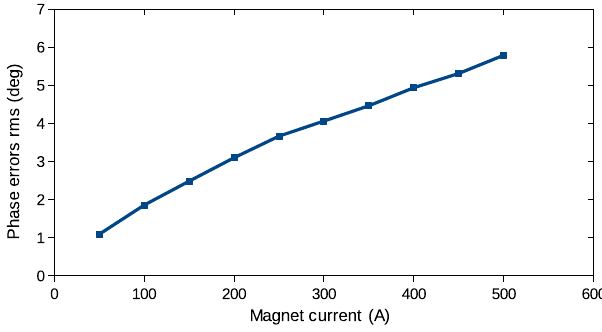
FIG. 11. Measured phase errors as a function of magnet current.